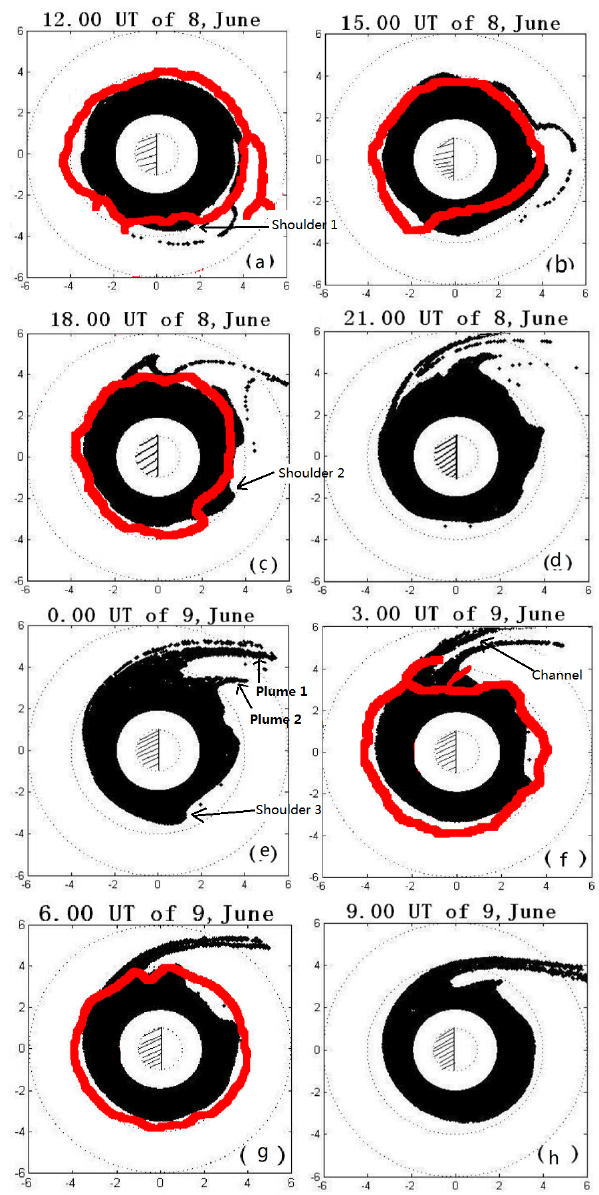
Figure 3. The simulation of plasmaspheric morphology compared with EUV/IMAGE observation in the geomagnetic equatorial plane on 8–9 June 2001. The red irregular curves indicate plasmapause observation by EUV/IMAGE. Black contours are the plasmasphere simulated by the TPM model. White contours are the main plasma- sphere (located at 1–2 R E region). The dotted circles on the panels correspond to L = 1, 2, 4 and